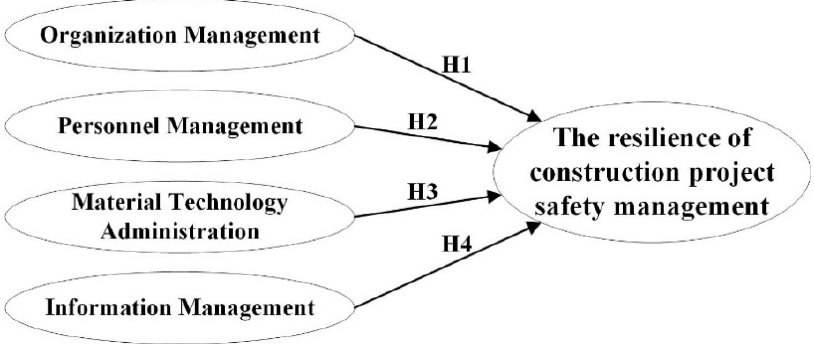
Figure 2. The hypothetical model.